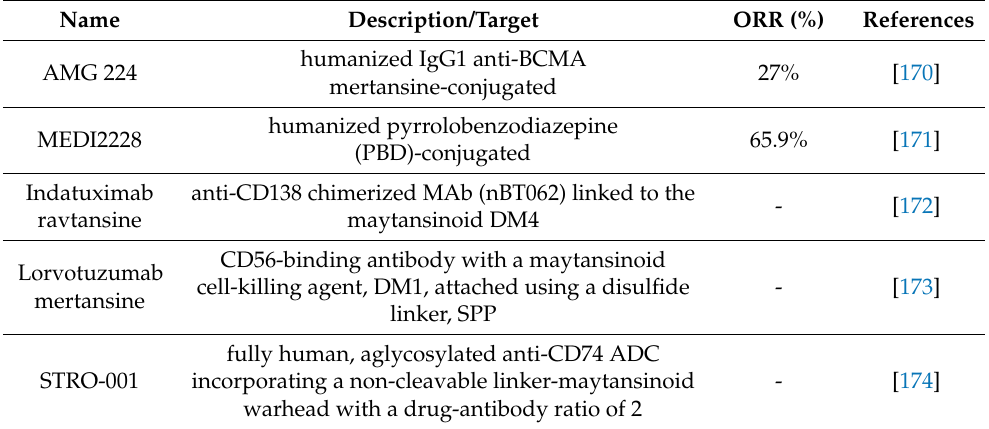
Table 3. Other ADCs in